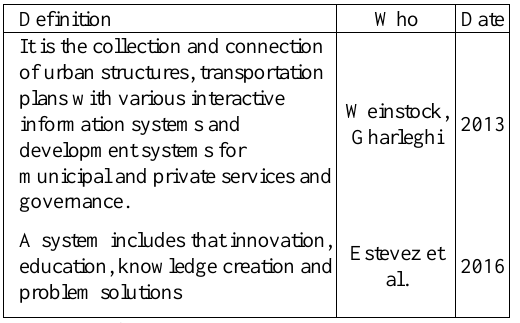
Table 4. Definitions in literature about intelligent cities